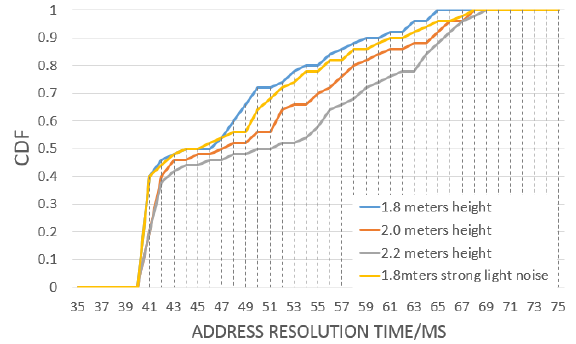
Figure 8. Middle region location time & resolution success